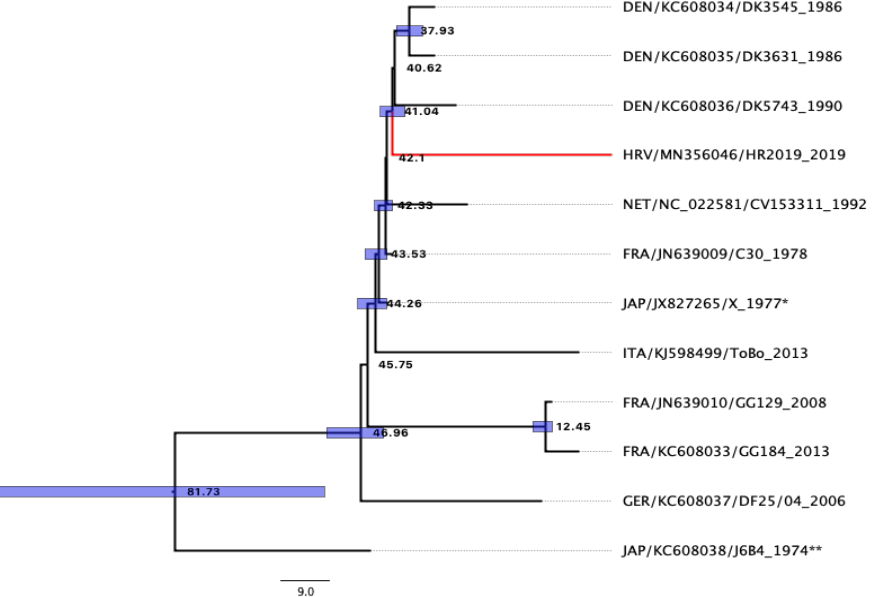
Figure 3. Unrooted Maximum-likelihood (ML) phylogenetic tree of the genus Anguilla inferred from the cytochrome b coding (COI) region of mtDNA. HR samples 1–5 were the individuals studied. COI sequence data are labelled with their GenBank accession numbers. Numbers at nodes are bootstrap percentages (>90%) after 1000 replicates based on distance. The scale bar represents an interval of the Kimura two-parameter (K2P) model.